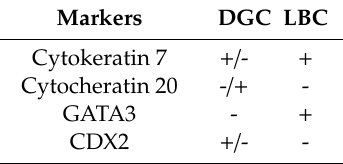
Table 1. Panel of expressed markers in di ff use gastric cancer (DGC) and / or lobular breast cancer